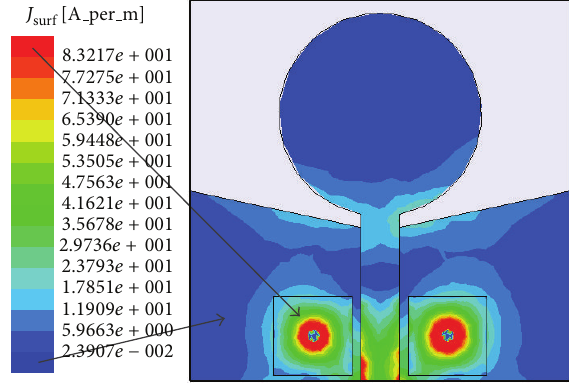
Figure 7: Surface current distribution on UWB antenna with EBG structures at 5.5